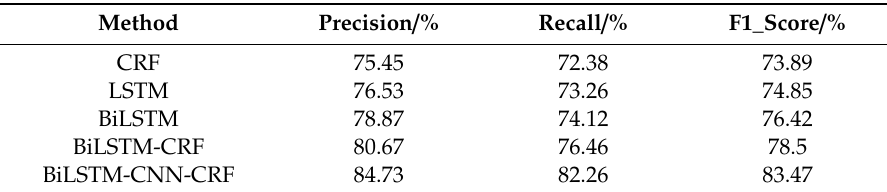
Table 8. Comparison of experimental results of different methods.